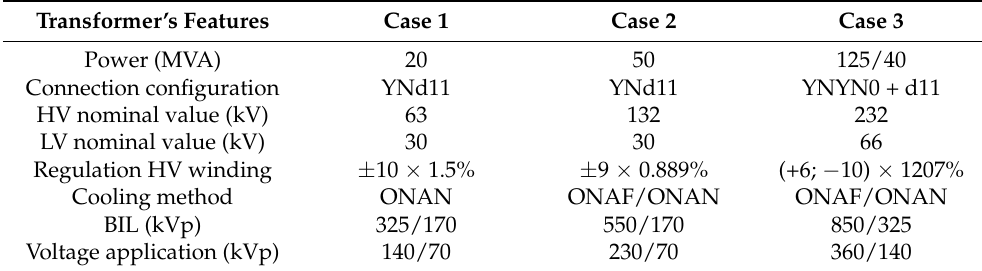
Table 1. Transformers’ general data features.